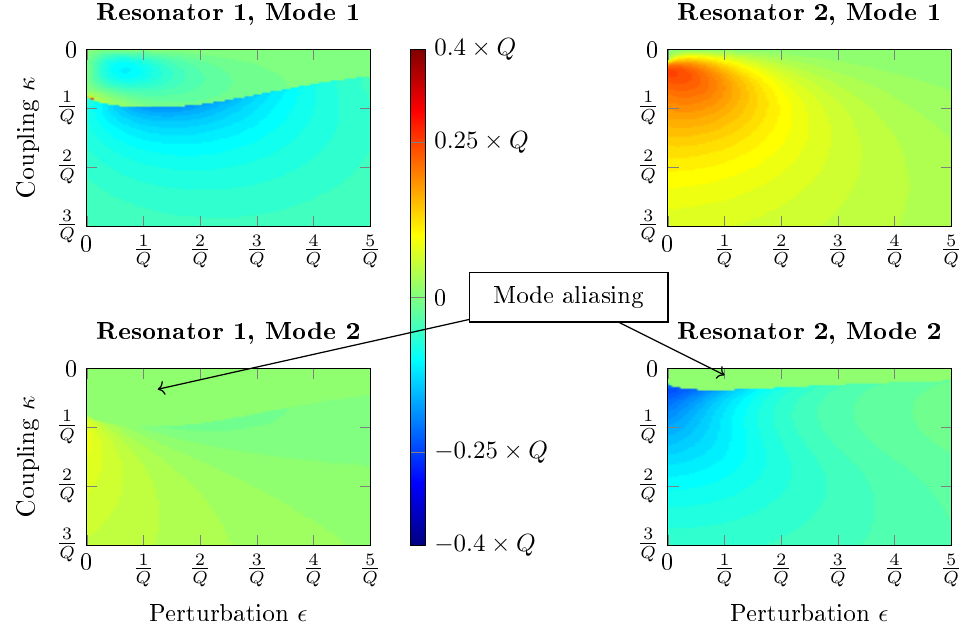
Figure 2. NS graphics of a 2 DoF damped resonators system with a mass perturbation on resonator 2. Output metrics: Resonance amplitude shift. The reference amplitude is the resonant amplitude of a single